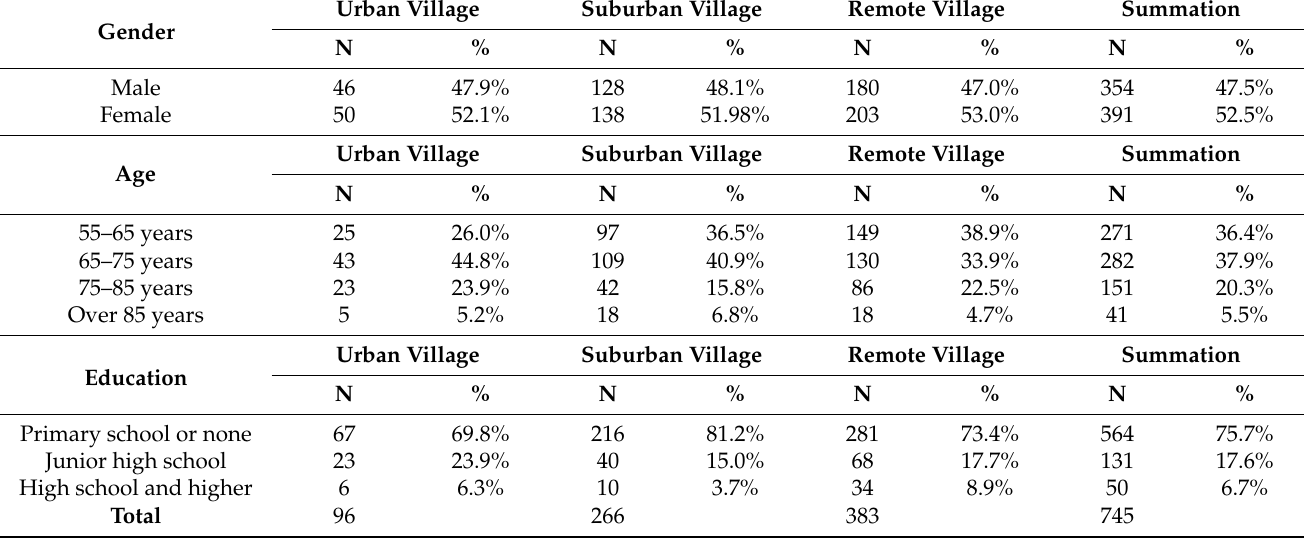
Table 1. Basic information about the elderly in the selected